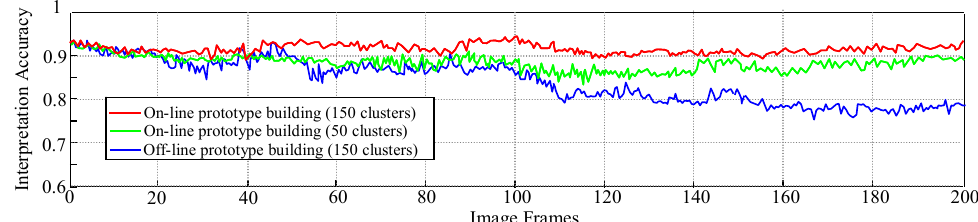
Figure 21. Far-field interpretation accuracy for different prototype building mechanisms.